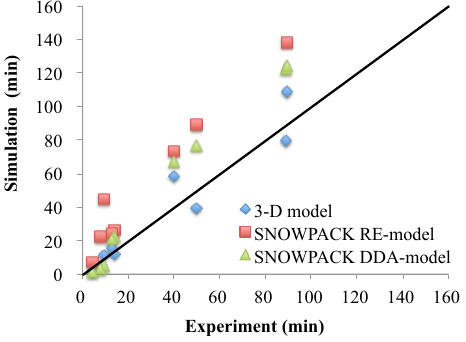
Figure 7. Comparison of water arrival between a laboratory exper- iment, a 3-D model and two SNOWPACK